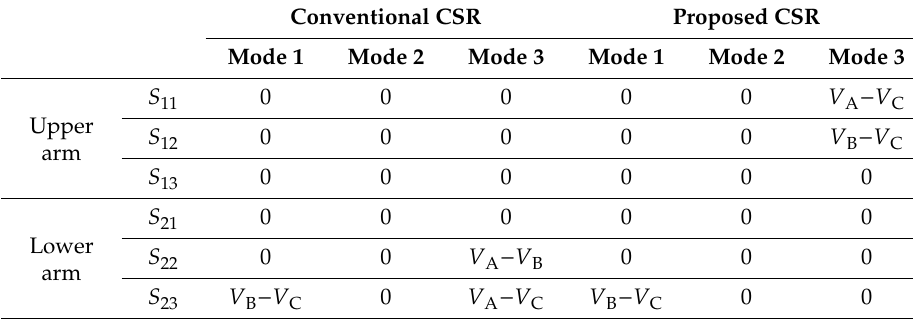
Table 2. Voltage stress of di ff erent CSRs in sector 1.